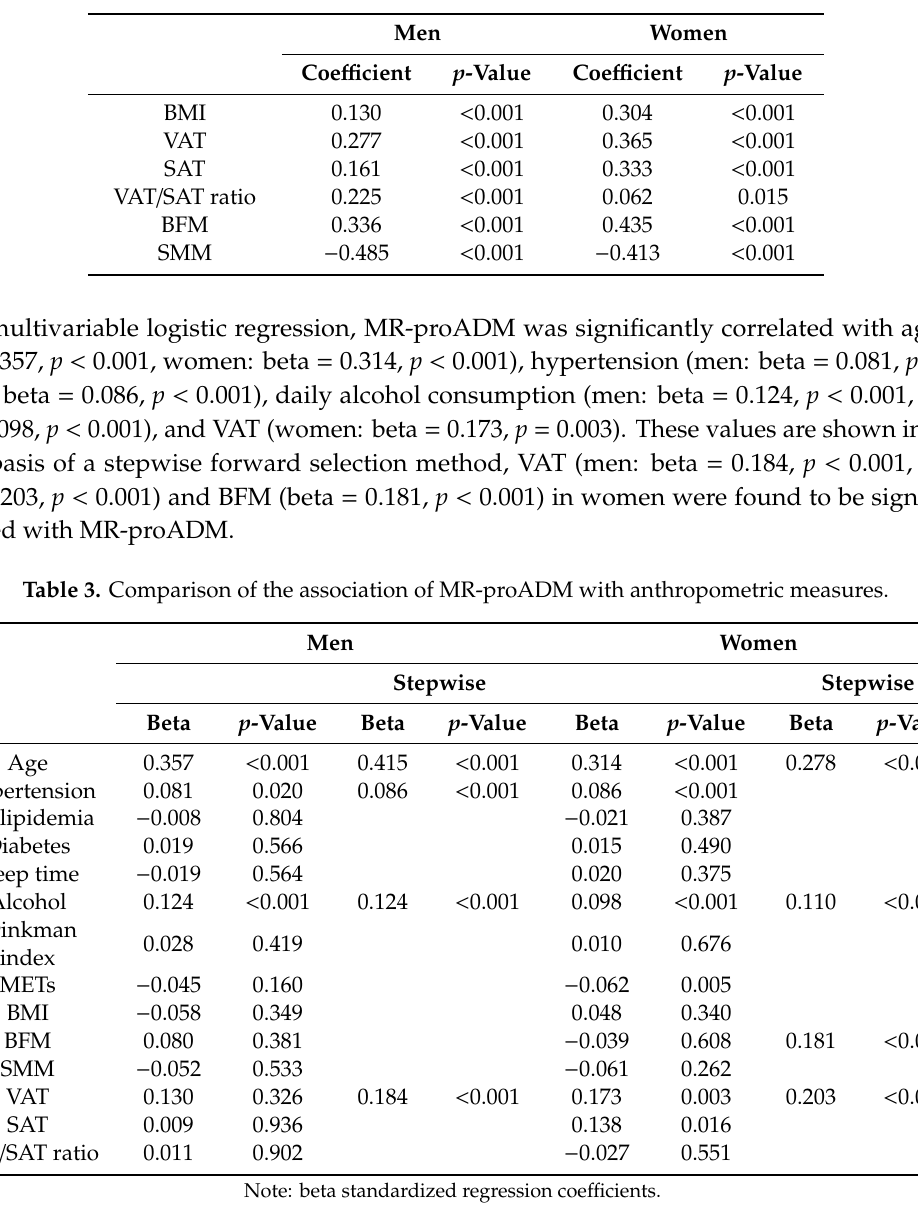
Table 2. Correlations between midregional proadrenomedullin (MR-proADM) and anthropometric indices.